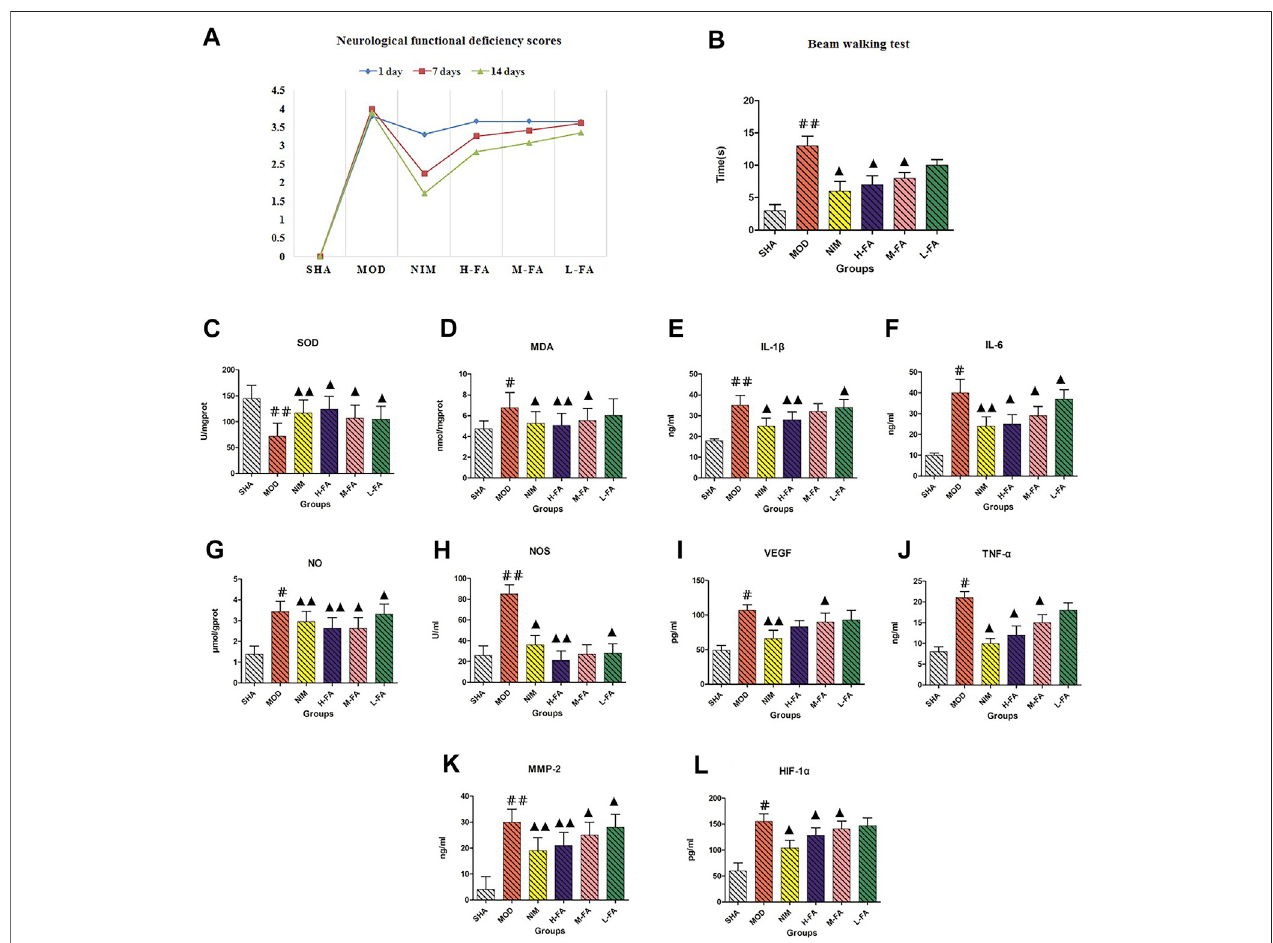
FIGURE1| Thecomparisonofneurologicalfunctionalde fi ciencyscores,totaltimesinbeamwalkingtest,andchemicalindicatorchangesbetweentheSHA,MOD, NIM,L-FA,M-FA,andH-FAgroups( n =8ineverygroup).Datawithstatisticalsigni fi cancearerepresentedas"#"or “ ▲ ” witha p -valuelessthan0.05.Datawithstatistical signi fi cance are represented as "##" or “ ▲▲ ” with a p -value less than